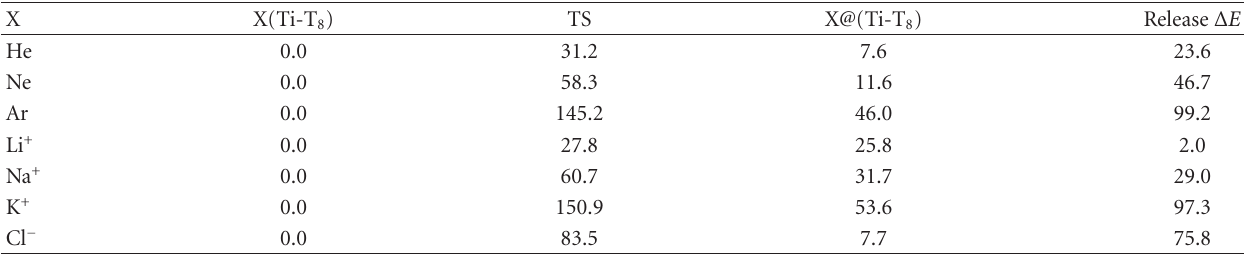
Table 4: The B3LYP/6-311+G(d)+ZPC relative energy (kcal/mol) of the exohedral (X(Ti-T8)) and endohedral (X@(Ti-T8)) complexes (X = He, Ne, Ar, Li + , Na + , K + , and Cl − ) and the transition state (TS) connecting them and the release energy ( Δ E ) of X from the endohedral